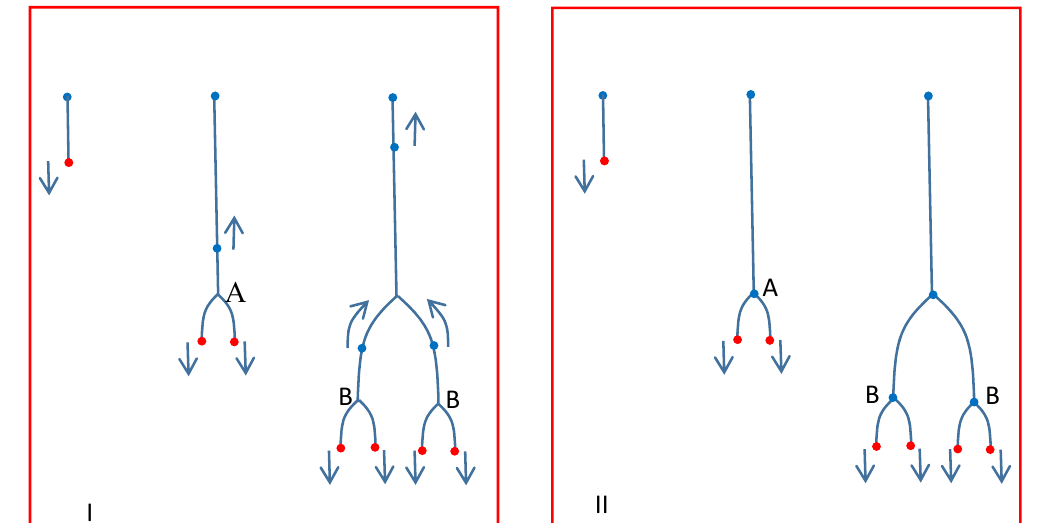
Figure 4 . In the analysis, a streamer is considered as a propagating positive charge distribution (marked by red dots). As the streamer branches, new streamer heads are created and there are two possible scenarios for the fate of the resulting negative charge (represented by blue dots). ( I ) In this scenario, the negative charge travels towards the origin of the streamer and is accumulated there. ( II ) In this scenario, the negative charge remains at the same location where it is created. The arrows indicate the direction of travel of the charge distributions.